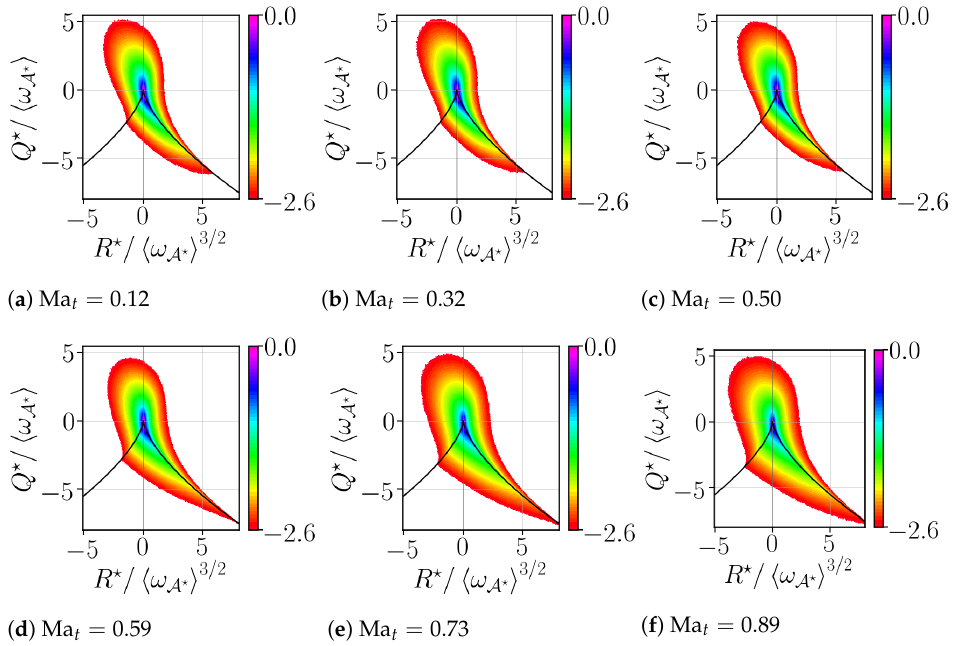
Figure 5. Joint PDF of the invariants Q (cid:63) and R (cid:63) as function of Ma t . Table 2. Occupancy of different regions of Figure 2 for the velocity gradient tensor, A (cid:63) , expressed as a percentage of realizations. The last column indicates the non-rotational non-degenerate topology, where (cid:107) R (cid:63) (cid:107) is the Frobenius norm of R (cid:63) . Ma t UFC SFS SNSS UNSS (cid:107)R (cid:63) (cid:107) =